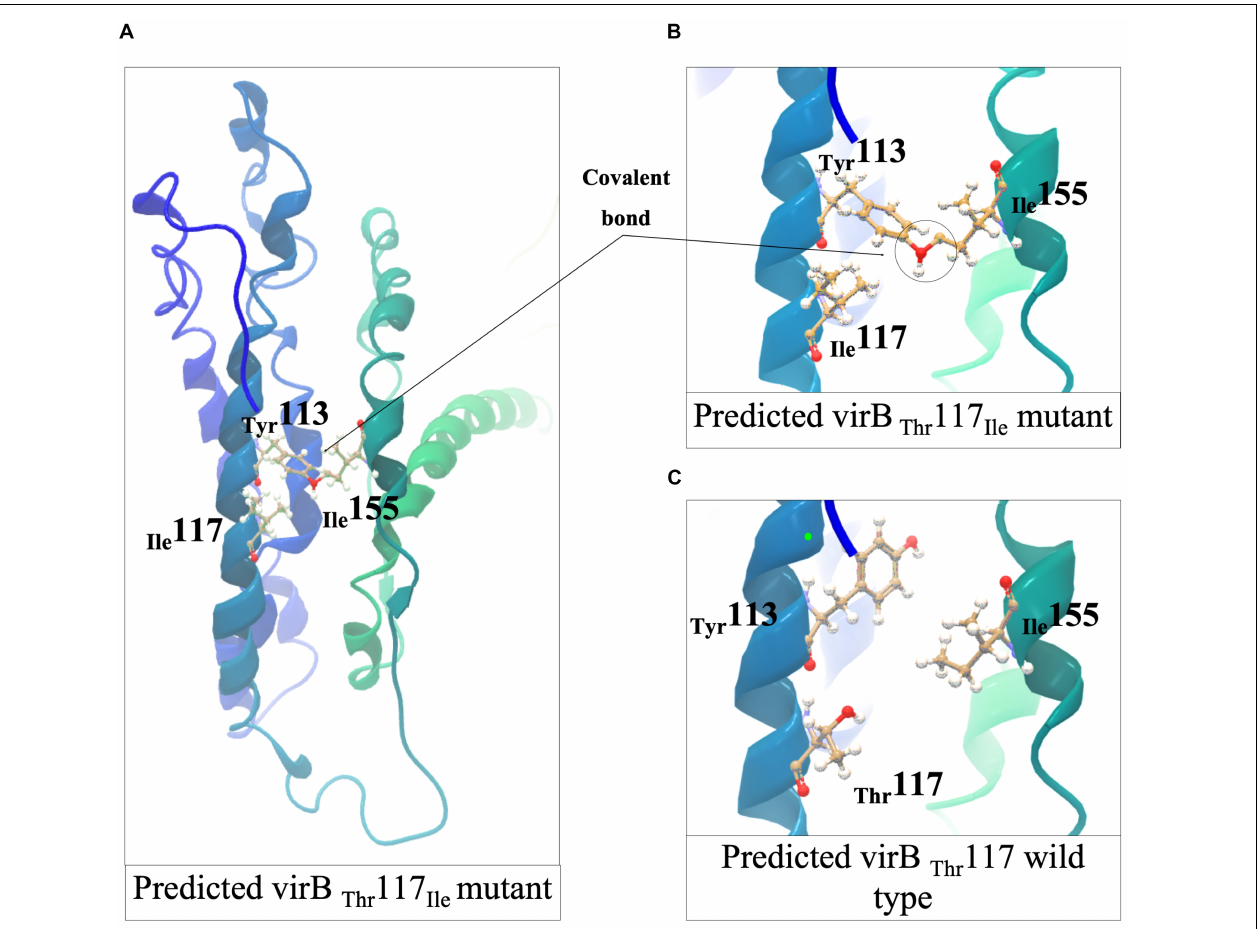
FIGURE 9 | Structural predictions and analyses of the L. monocytogenes VirB I117T mutant protein. (A,B) The formation of a covalent bond between T 132 and I 155 in opposite a-helixes in VirB I117T mutant predicted using Phyre2. (C) Missense3D-predicted T117I (VirB wild type) compliment showed the covalent bond in T 113 and I 155 could be broken after I117T complementation. The figures were generated in CLC Genomics Workbench.